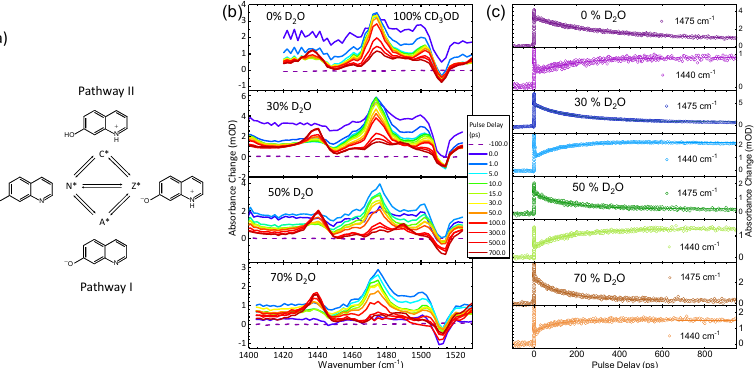
We present here experimental and theoretical results on ultrafast dynamics of 7‐ hydroxyquinoline (7HQ) in water/methanol mixtures of various relative composition. Here 7HQ is excited in its neutral form N*, that then converts to the zwitterionic tautomer Z* on picosecond time scales. We have reported in a UV/IR pump‐probe study the time constants of particular proton transfer steps of differently charged forms of 7HQ in deuterated methanol [6]. Here we expand on our previous results by measuring femtosecond UV/IR pump‐spectra of 7HQ in D 2 O/CD 3 OD mixtures (Figure 1b,c).